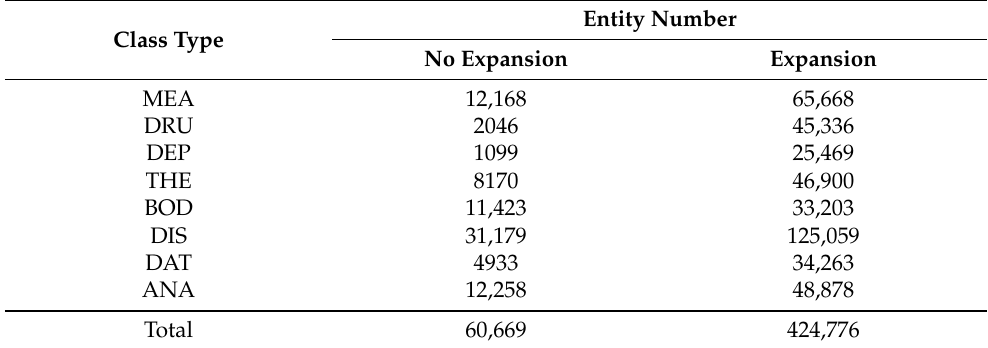
Table 3. Number of entities in the annotated corpus before and after the application of DS entity ex- pansion.